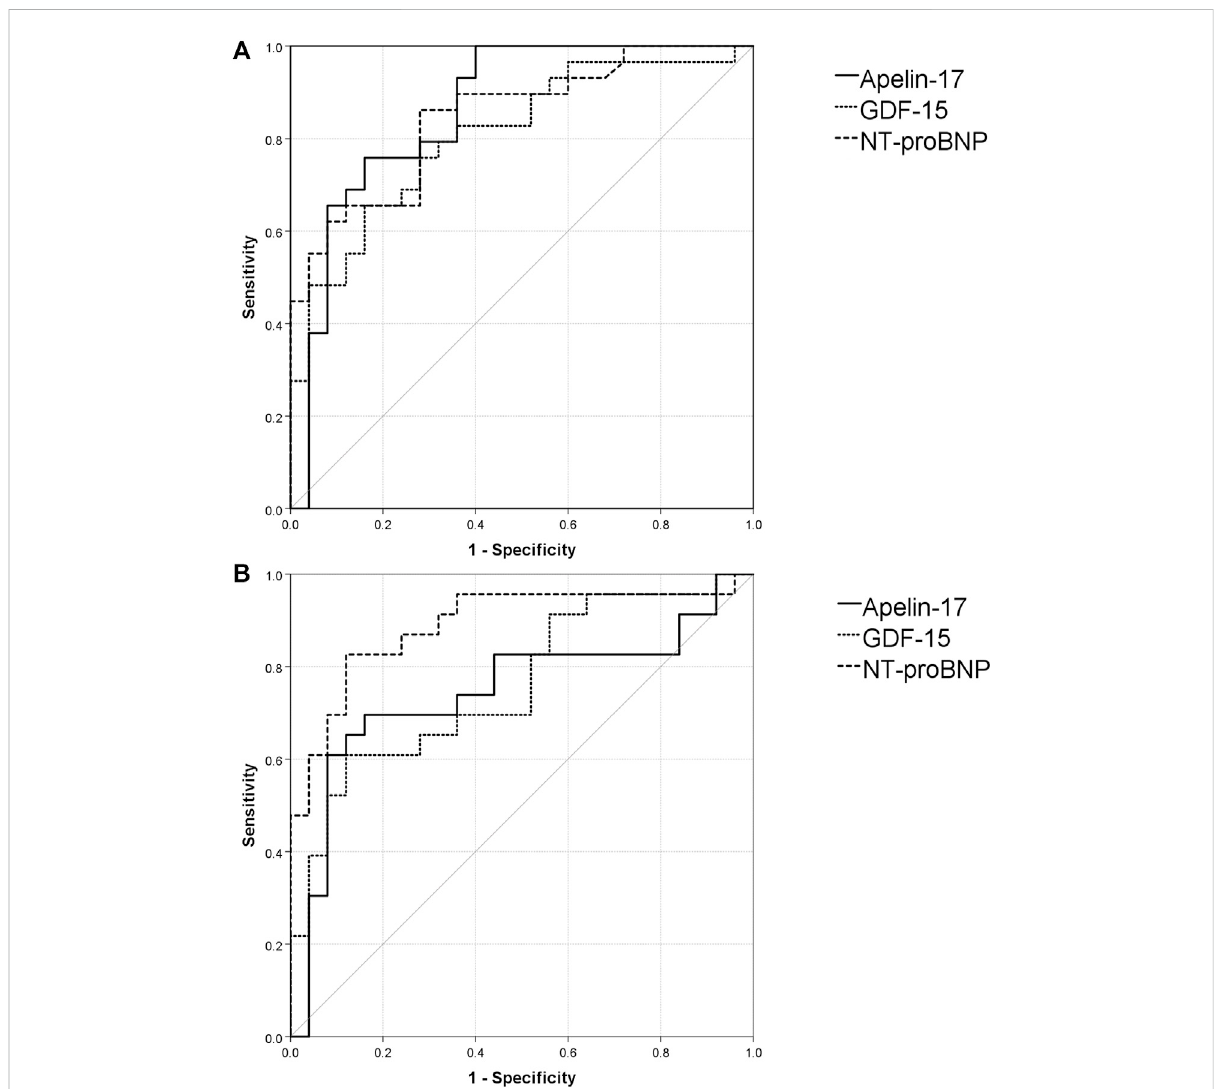
FIGURE 2 Receiveroperatingcurves andareaunderthecurveanalysis oftheinvestigatedmarkers.Values ofsensitivity(%)arerepresentedonthe Y axis. X axisrepresents100%-speci fi city(%). (A) .ROCcurvesforapelin-17,GDF-15andNT-proBNPforIPAH (B) .ROCcurvesforapelin-17,GDF-15andNT- proBNP for CTEPH.